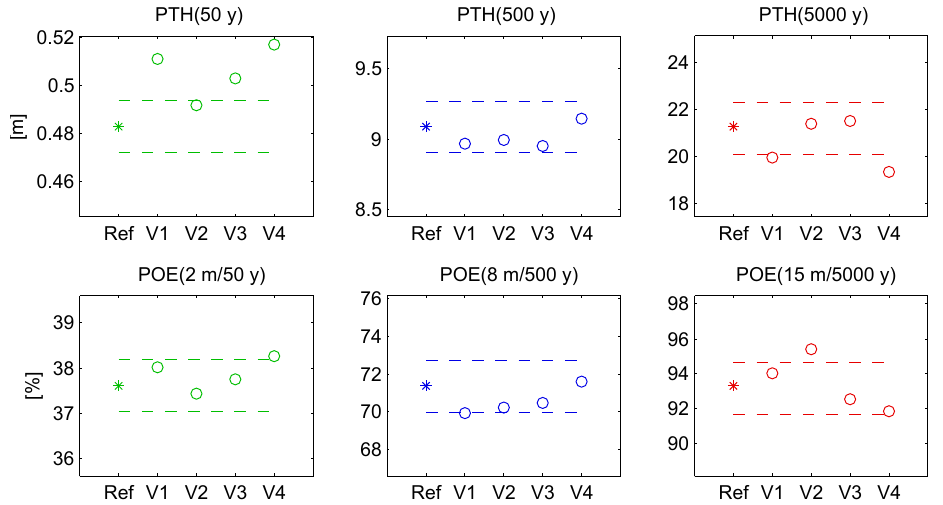
Figure B2. Hazard results (Iran & Pakistan) for the reference synthetic catalog (stars) and four additional test catalogs (circles). Dashed: 15th and 85th